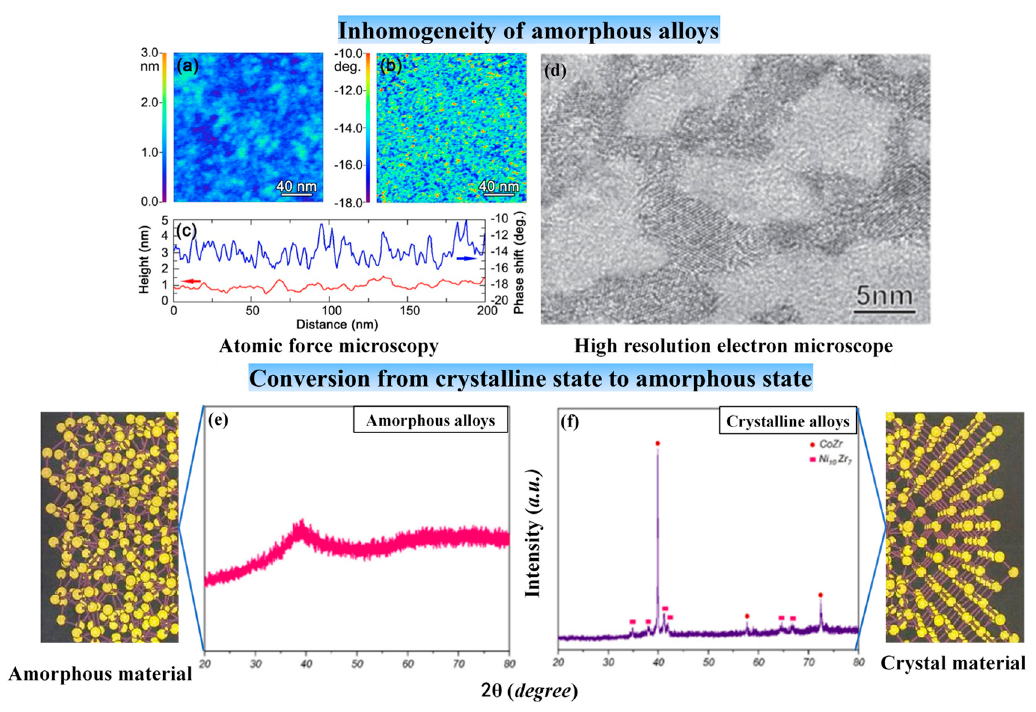
Figure 3. ( a ) The height image with rms roughness of ~0.3 nm and ( b ) phase shift image. ( c ) Height and phase shift profiles taken from the same region (The blue line refers to the phase shift, while the red line refers to the height), adapted with permission from Ref. [14] 2000, APS. ( d ) Amorphous alloys after ultrasonic vibration treatment show the appearance of soft and hard regions, adapted with permission from Ref. [15] 2005, APS. ( e ) XRD pattern of amorphous alloy. ( f ) XRD pattern of the crystalline amorphous alloy, adapted with permission from Ref. [12] 2022, Elsevier.